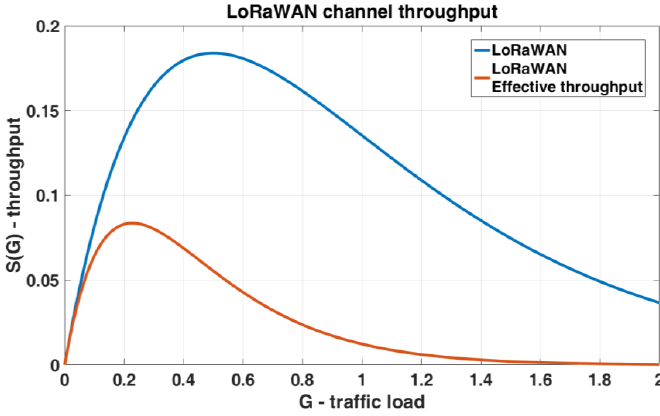
Figure 5. Unconfirmed and confirmed LoRaWAN single channel throughput. Sensors 2018 , 18 , x FOR PEER REVIEW